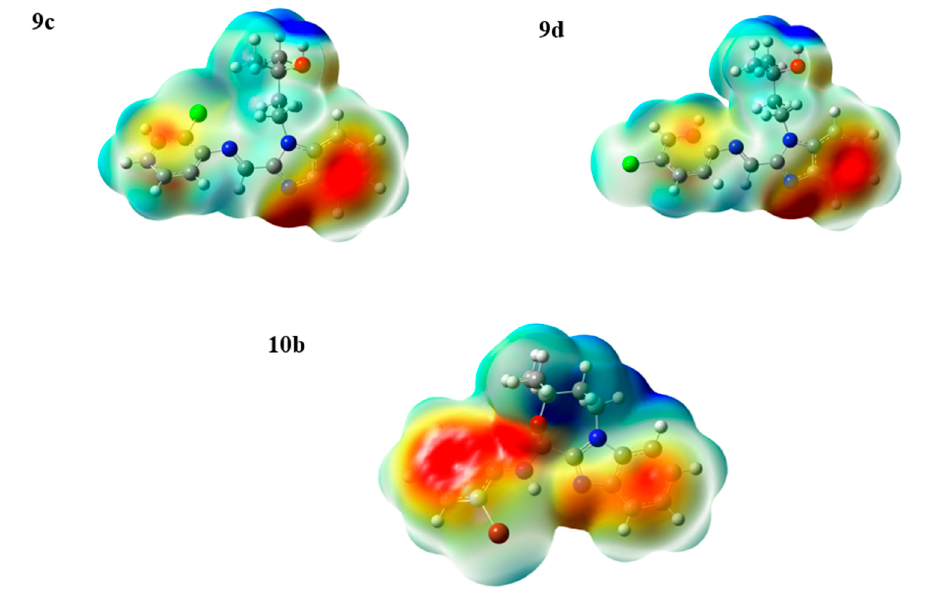
Figure 5. Molecular electrostatic potentials (MEP) mapped on the electron density surface calculated by the DFT/B3LYP method.